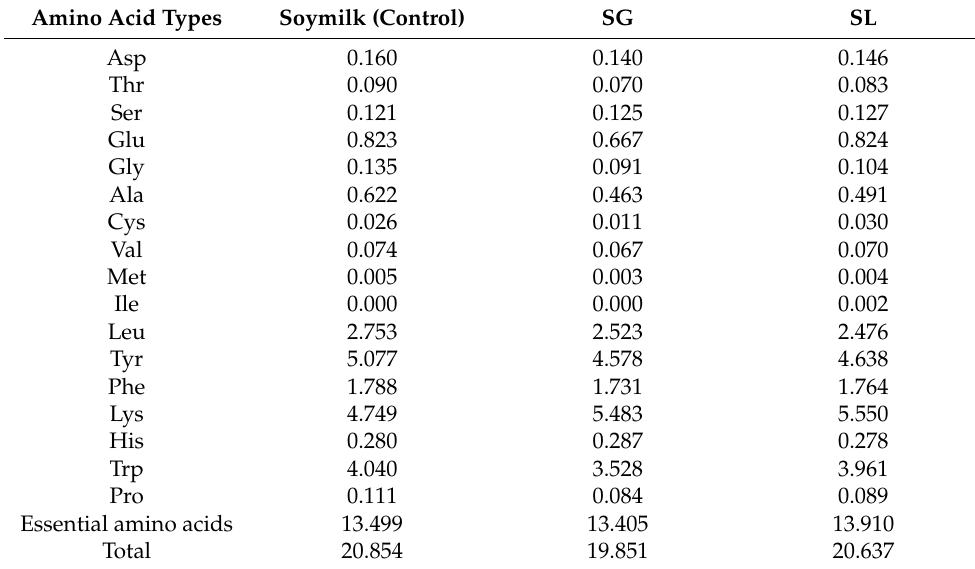
Table 2. Free levels of soymilk and both soymilk gels at the end of in vitro digestion. The results are presented in grams per liter of digestion